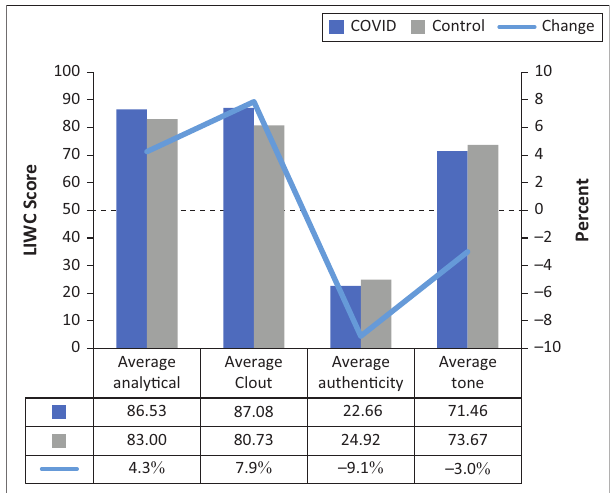
FIGURE 1: Linguistic Inquiry Word Count results.